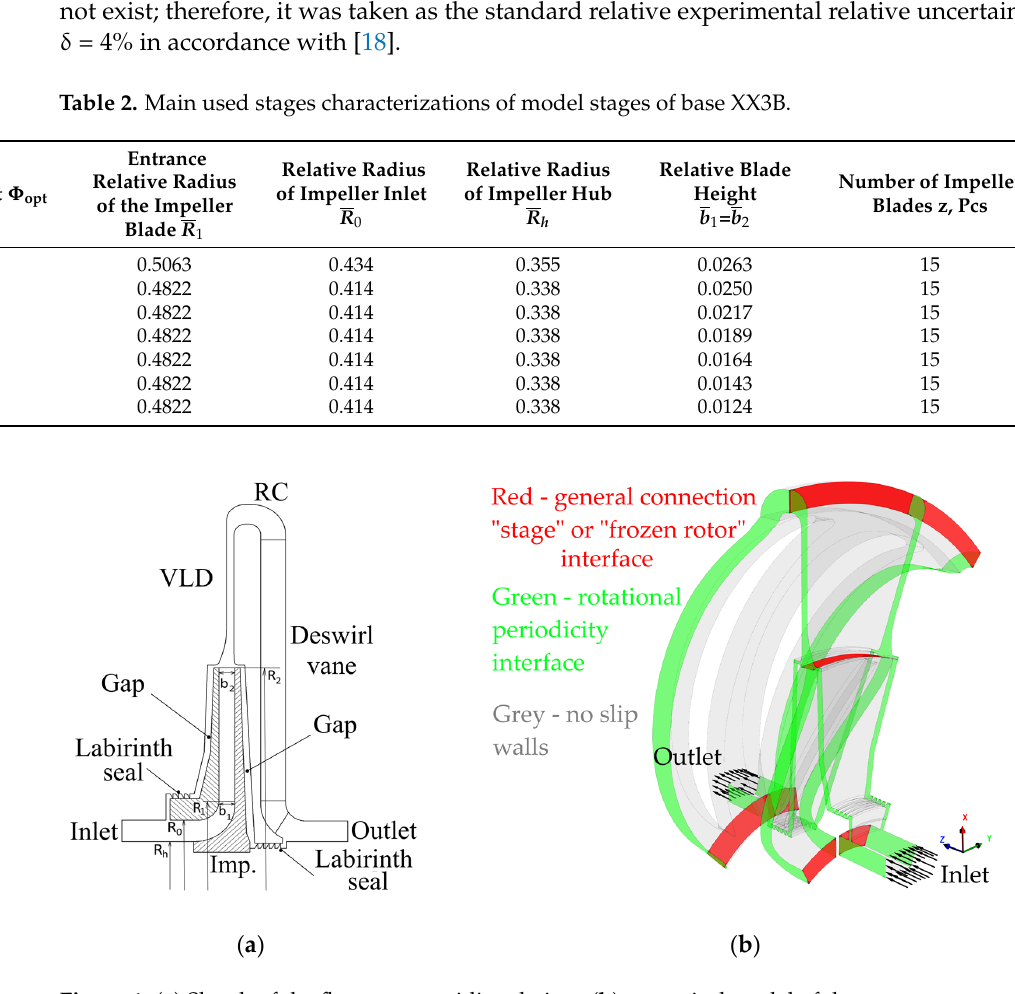
Figure 1. ( a ) Sketch of the flow part meridional view; ( b ) numerical model of the stage. Processing of the results was carried out according to the following dependencies.